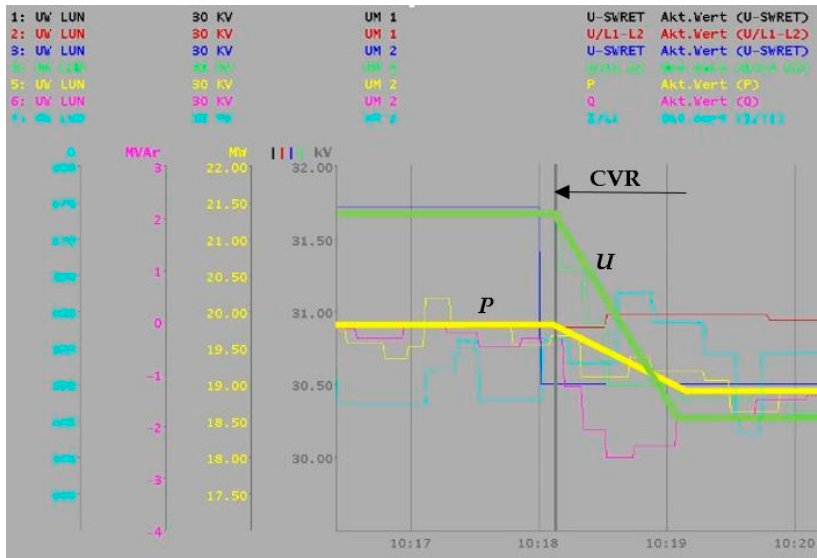
Figure 20. Voltage and active power course during the execution of the conservation voltage reduction (CVR) process in the ZUQDE project [76].